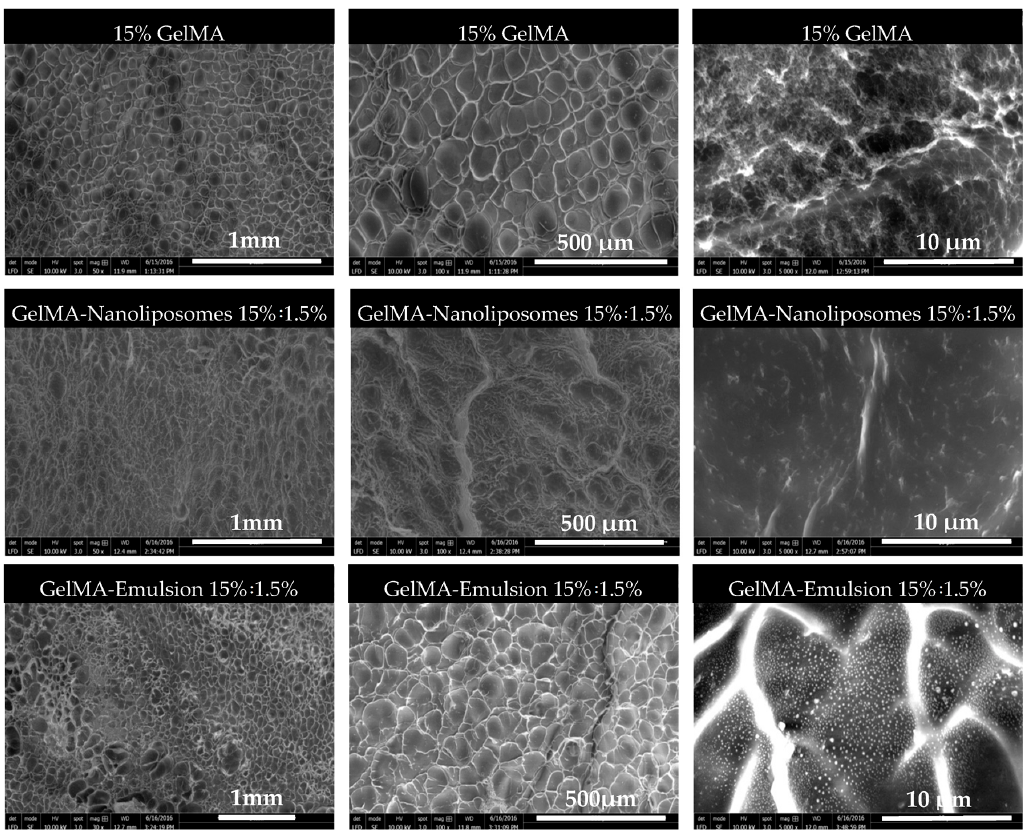
Figure 3. Scanning electron microscopy (SEM) images of 3D hydrogels (GelMA, GelMA-Nanoliposomes, and GelMA-Emulsion).